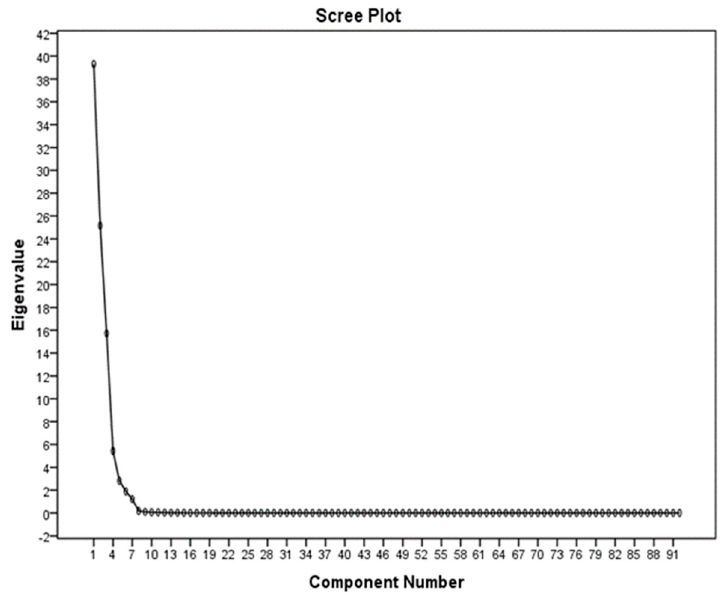
Figure 12. Scree plot to determine the most e ff ective separator components. White rice